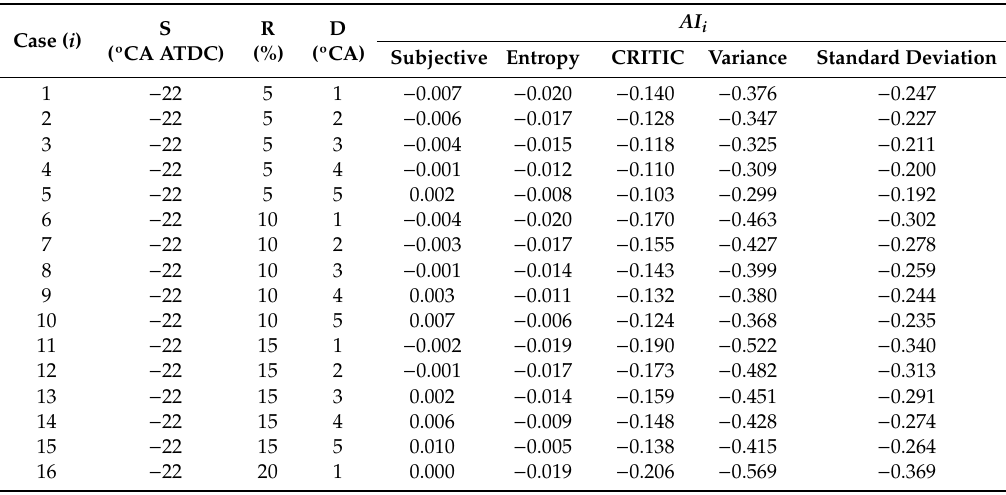
Table 5. Adequacy index according to subjective, entropy, CRITIC, variance, and standard deviation weighting